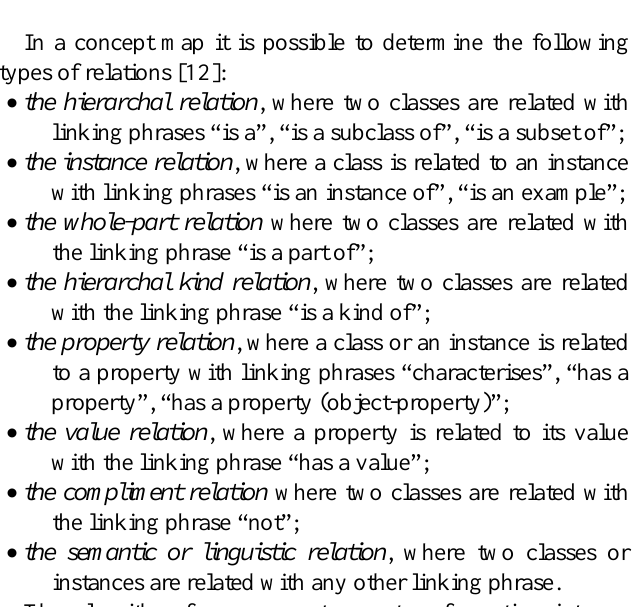
Fig. 4. Correspondence between elements of concept map and elements of ontology [12]